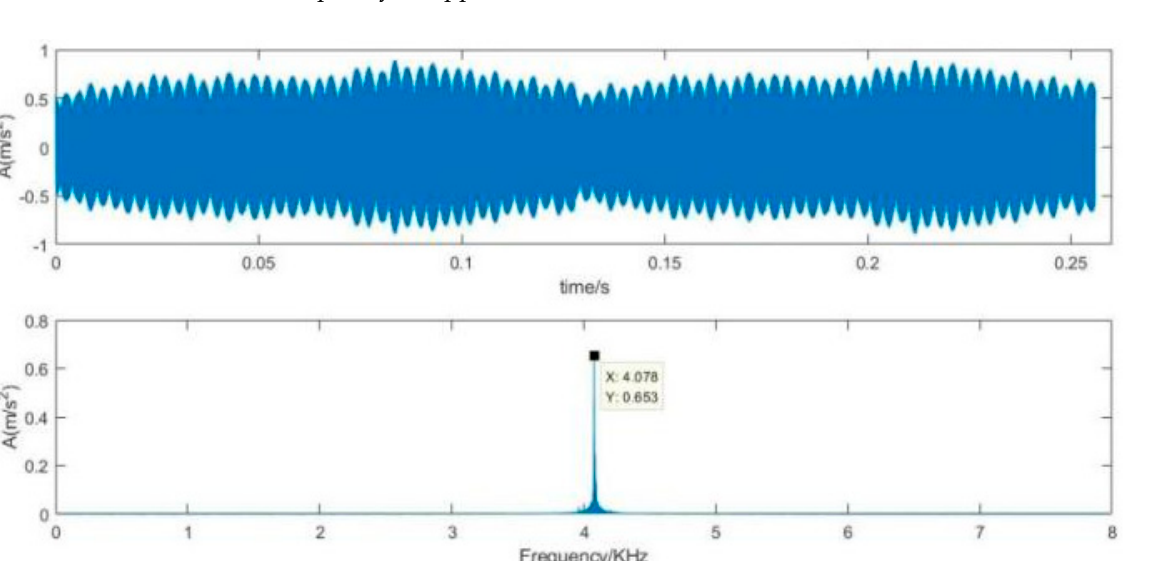
Table 2. Comparison between SVD-DS and SVD-VMD for simulated signals.